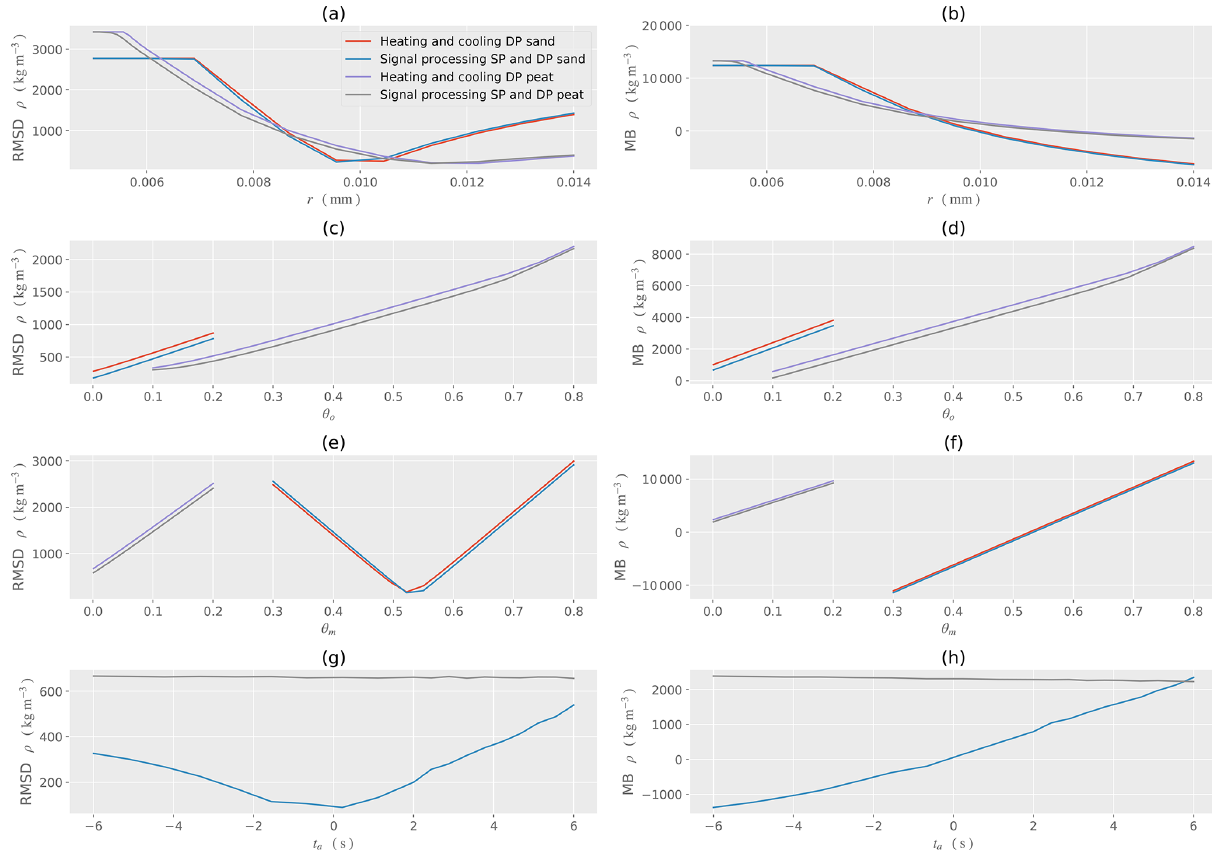
Figure 10. Sensitivity analysis for density ρ for sand and peat with respect to the different models. (a) RMSD for changes in the calibrated initial radius r . (b) MB for changes in the calibrated initial radius. (c) RMSD for changes in the organic volume fraction θ o . (d) MB for changes in the organic volume fraction θ o . (e) RMSD for changes in the mineral volume fraction θ m . (f) MB for changes in the mineral volume fraction θ m . (g) RMSD for changes in the time delay t a . (h) MB for changes in the time delay t a